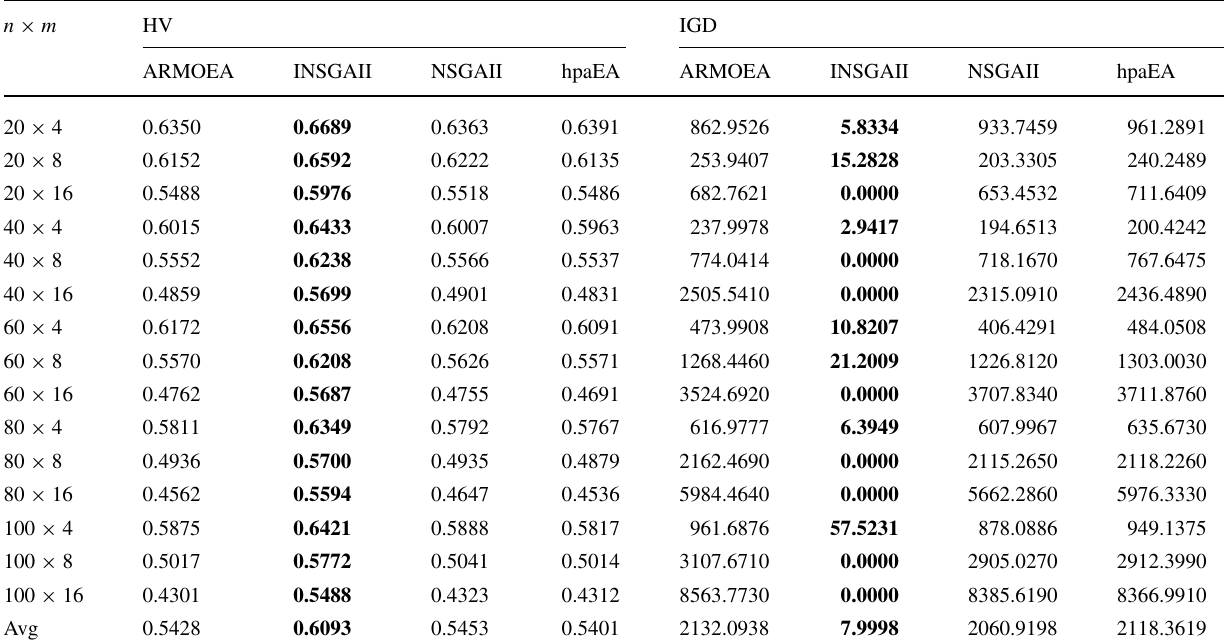
Table 10 Results of the algorithms ( g (cid:2) 2)